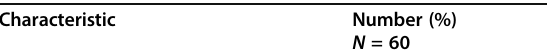
Table 1 Reporting of items applicable at the article